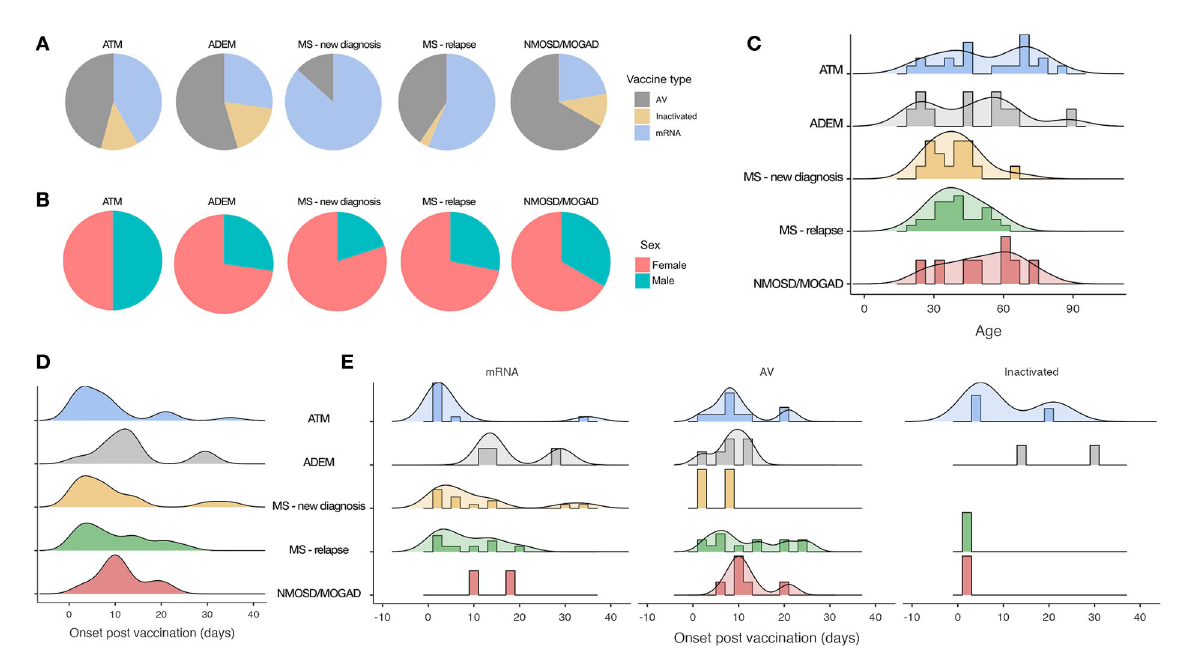
FIGURE4 Demographical characteristics and time of onset among different CIDEs. (A) Proportions of different vaccine types. (B) Proportions of sex categories. (C) Age distributions. (D) Overall time from vaccine to symptoms onset. (E) Time from vaccine to symptoms onset by vaccine type. AV, adenoviral-vectored